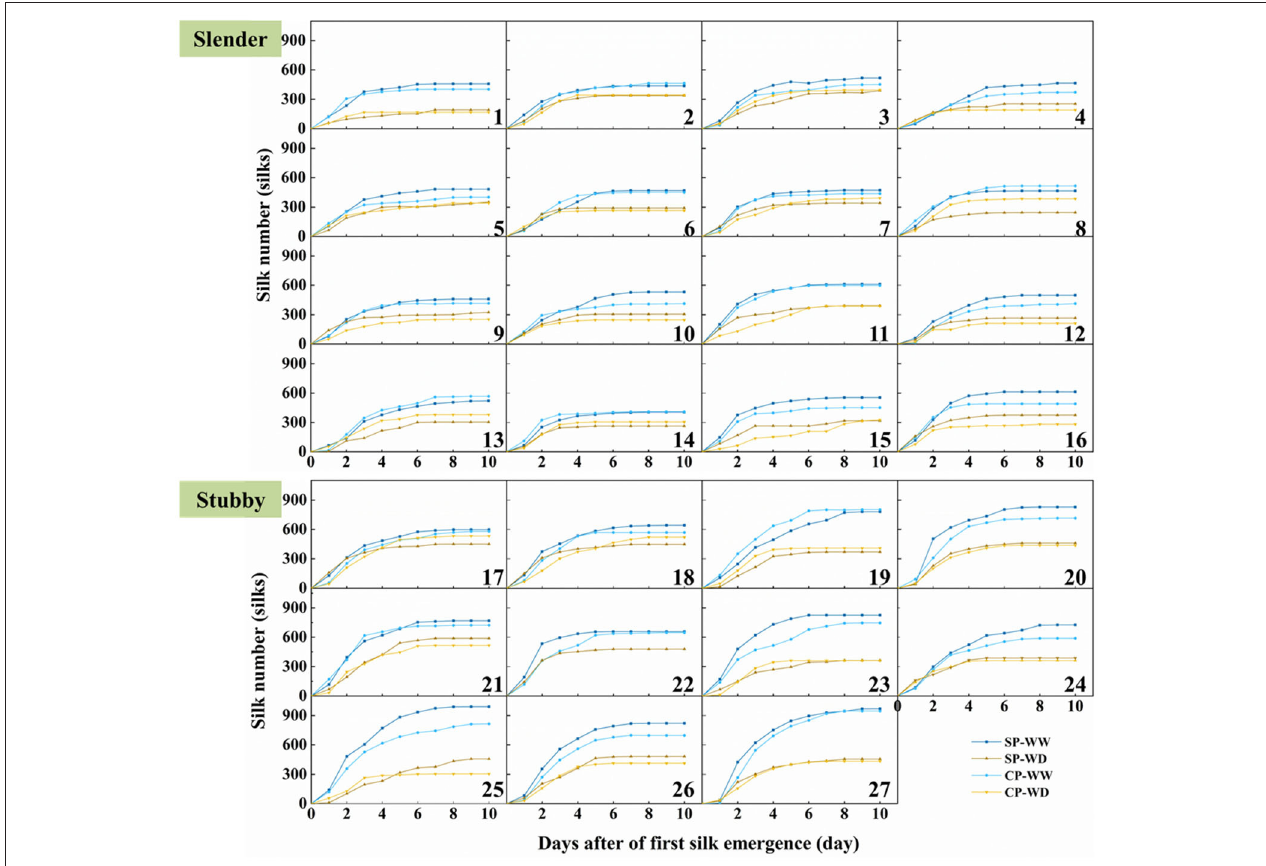
FIGURE 3 | Silk emergence dynamics of 27 maize hybrids in different pollination and water treatments. Hybrids 1–16 are slender ear, and hybrids 17–27 are stubby ear. SP, synchronous pollination; CP, continuous pollination; WW, well-watered treatment; WD, water-deficit treatment.